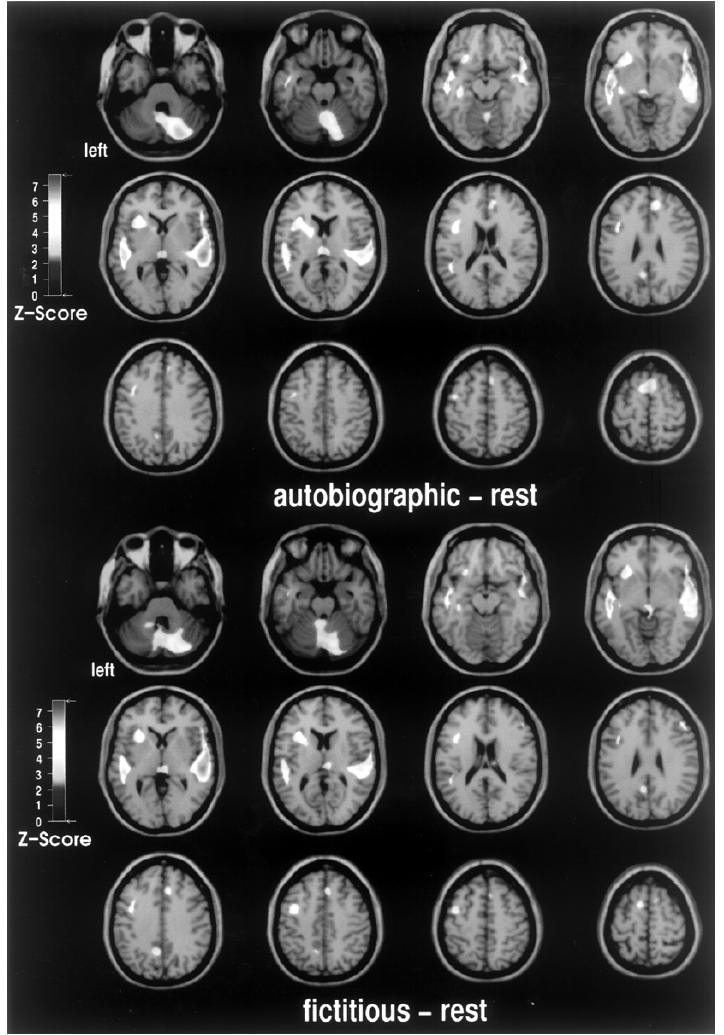
Fig. 2. Striking similarity of the brain activation patterns during affect-laden retrieval of real-life episodes (top; comparison AUTOBIO- GRAPHIC-REST) and invented episodes (bottom; comparison FICTITIOUS-REST). The SPM-map is sectioned in transverse planes and is displayed on top of an arbitrary magnetic resonance image that has been normalized spatially to the same anatomical space. The color bars indicate the Z statistics